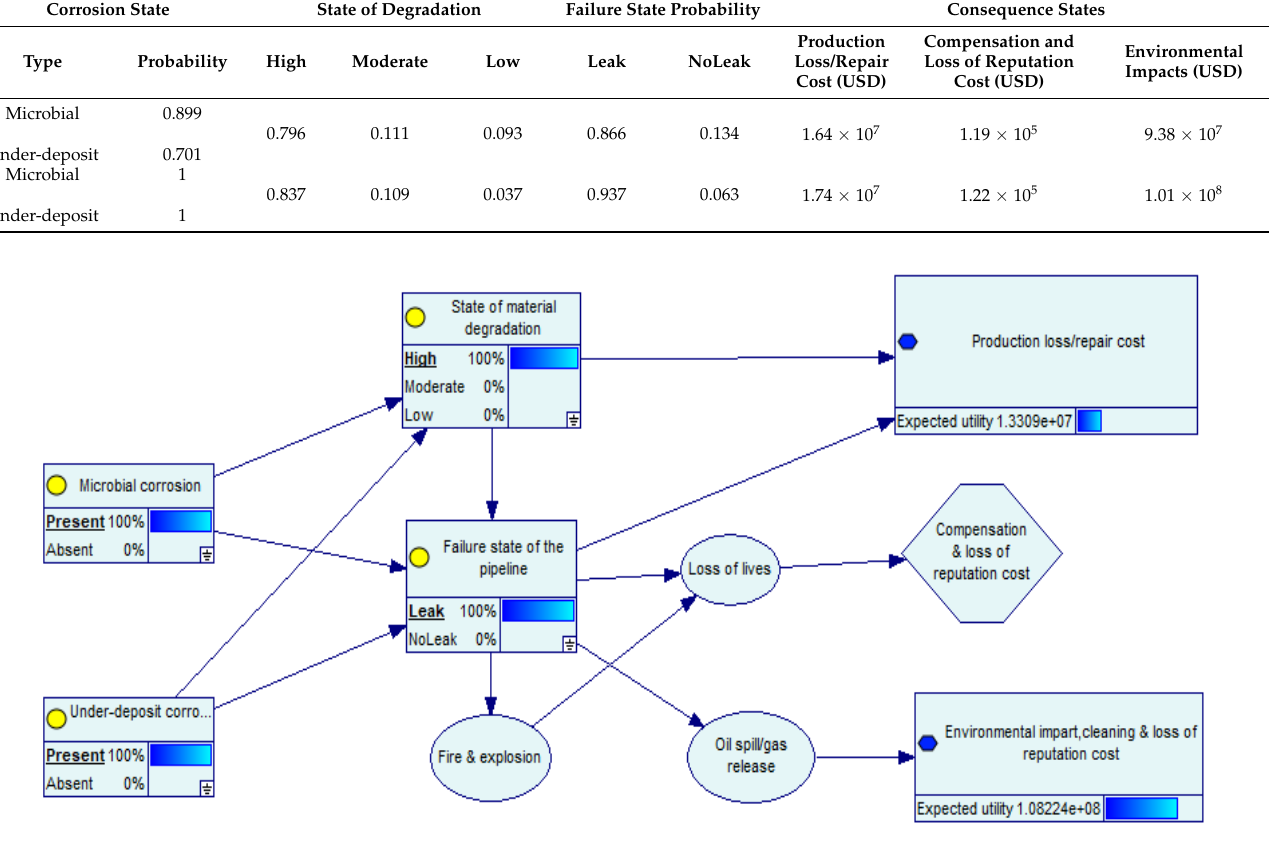
Table 1. Results of the parametric learning and evidence-based analysis of the case study.